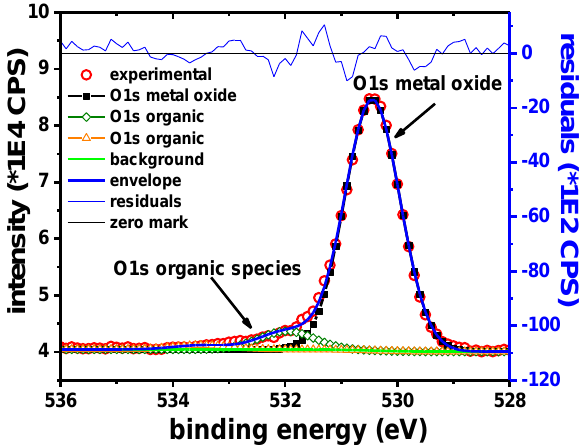
Figure 14. O1s narrow scan, Sn sample.